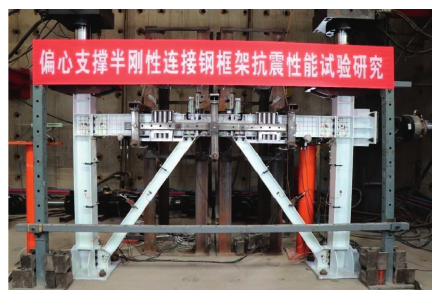
Figure 5: Test configuration.